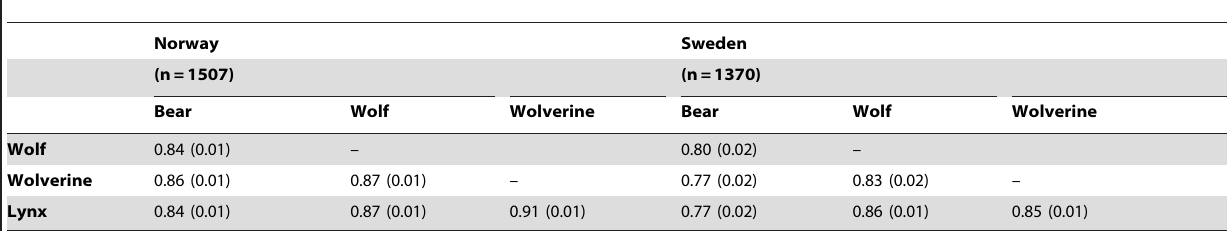
Table 3. Spearman correlation coefficients (r sp 6 SE r ) between acceptance to poach the different carnivore species at the level of the individual respondent (all p ,